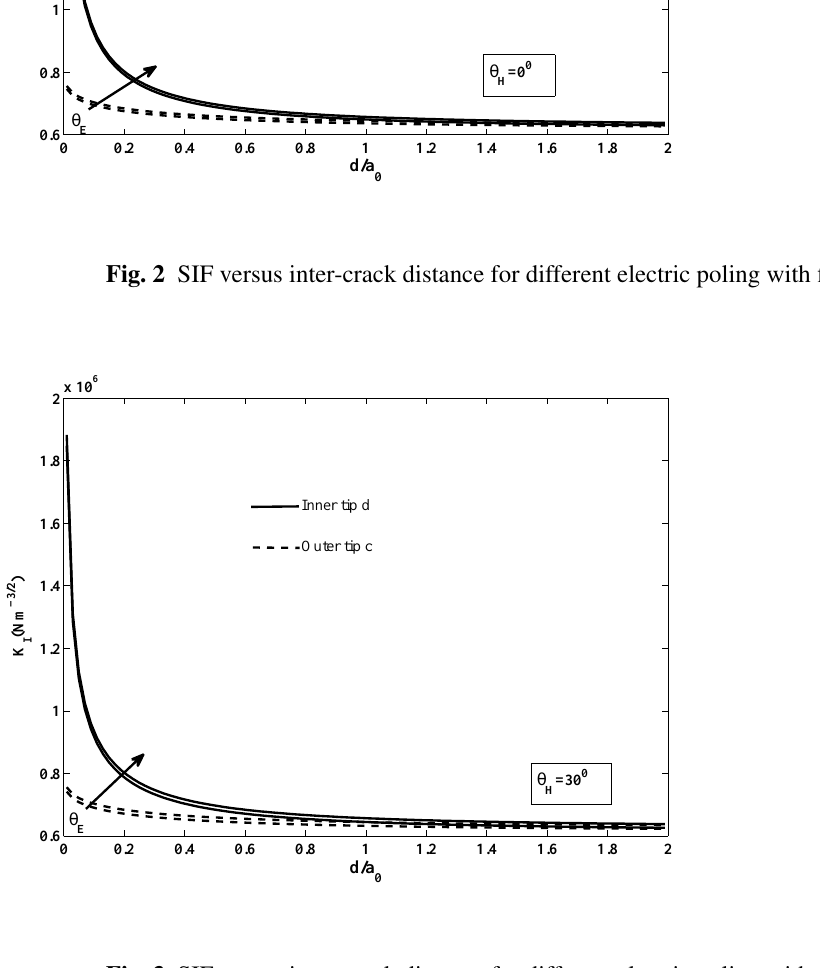
Fig. 3 SIF versus inter-crack distance for different electric poling with fixed magnetic